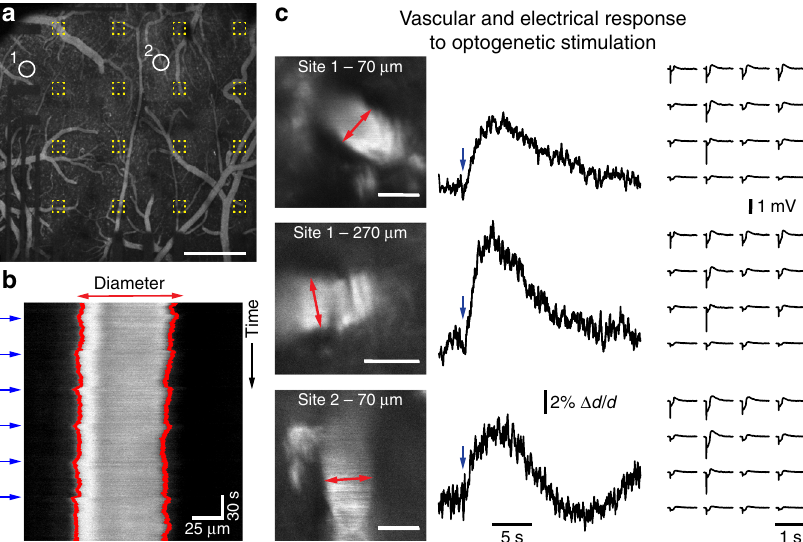
Fig. 6 Measurement of vascular responses to optogenetic (OG) photostimulation below graphene microelectrode arrays in Thy1-ChR2 mice. a Location of diving arterioles for diameter measurements with 2-photon imaging as shown in b , c . Yellow outlines indicate single graphene electrodes. Data was acquired after intravascular injection of FITC-dextran (2 MDa). Scale bar, 500 µ m. b Line-scan mode was used to measure time courses of single arteriole diameters; blue arrows indicate when a 473 nm laser stimulus was delivered, red lines indicate computed vessel borders used for estimation of diameter changes. c High-magni fi cation scans of arteriole segments are shown on the left (scale bars: 50 µ m); red arrows indicate line scan location. Vascular responses (diameter change relative to pre-stimulus baseline, Δ d / d ) averaged from fi ve to six photostimulation events (indicated by blue arrow) are shown in the middle; respective electrical responses to photostimulation measured with the graphene array are shown on the right. Note that stimulus intensities and illumination times used to elicit detectable vascular responses (50 – 100 ms at 7 mW) are larger than photostimulation shown in Fig. 5. Control experiment with a ChR2-negative animal is shown in Supplementary Fig.